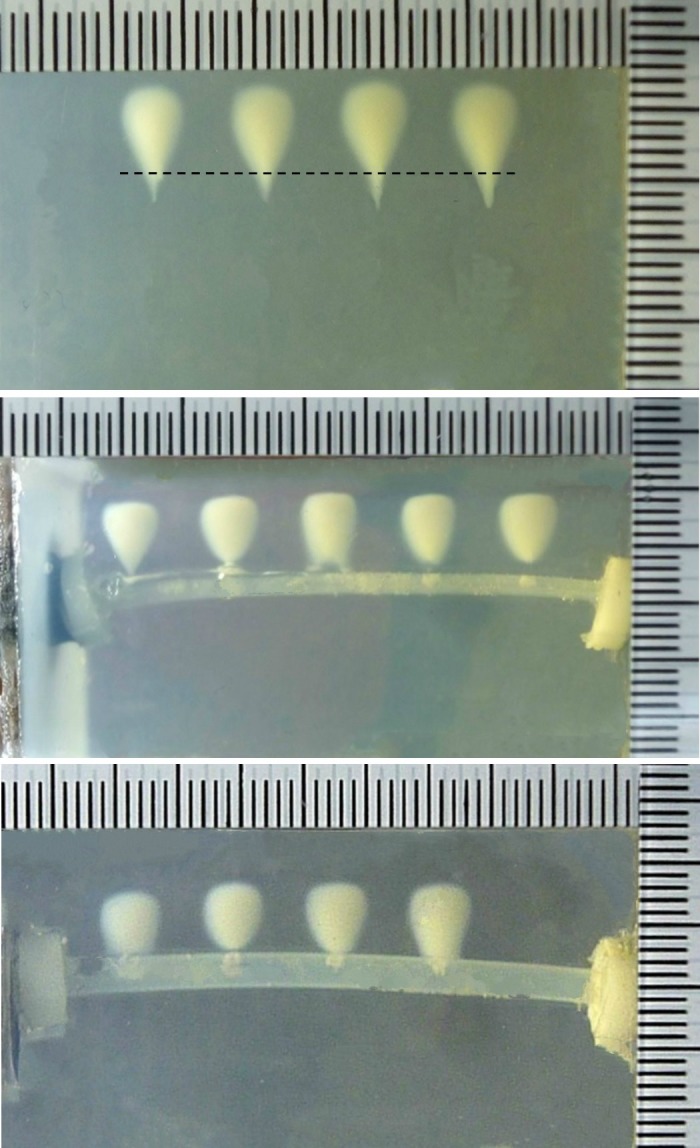
Representative photos of lesions produced (a) in a polyacrylamide gel phantom with 7% BSA after 100 s HIFU exposure at the peak negative pressure of -11.9 MPa, duty cycle of 20%, and pulse repetition frequency of 10 Hz (dashed line is the estimated HIFU focal plane), and close to (b) tubing 1, and (c) tubing 2 at the average flow speed of 267 m/s and 17 m/s, repectively.